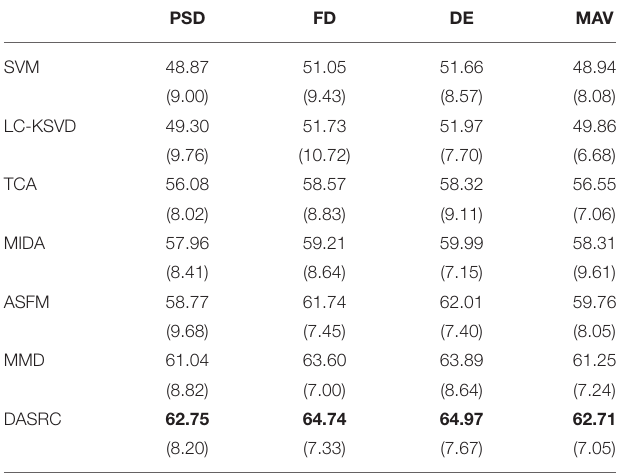
TABLE 3 | Cross-dataset accuracy % (std %) of DASRC using different features on DEAP →